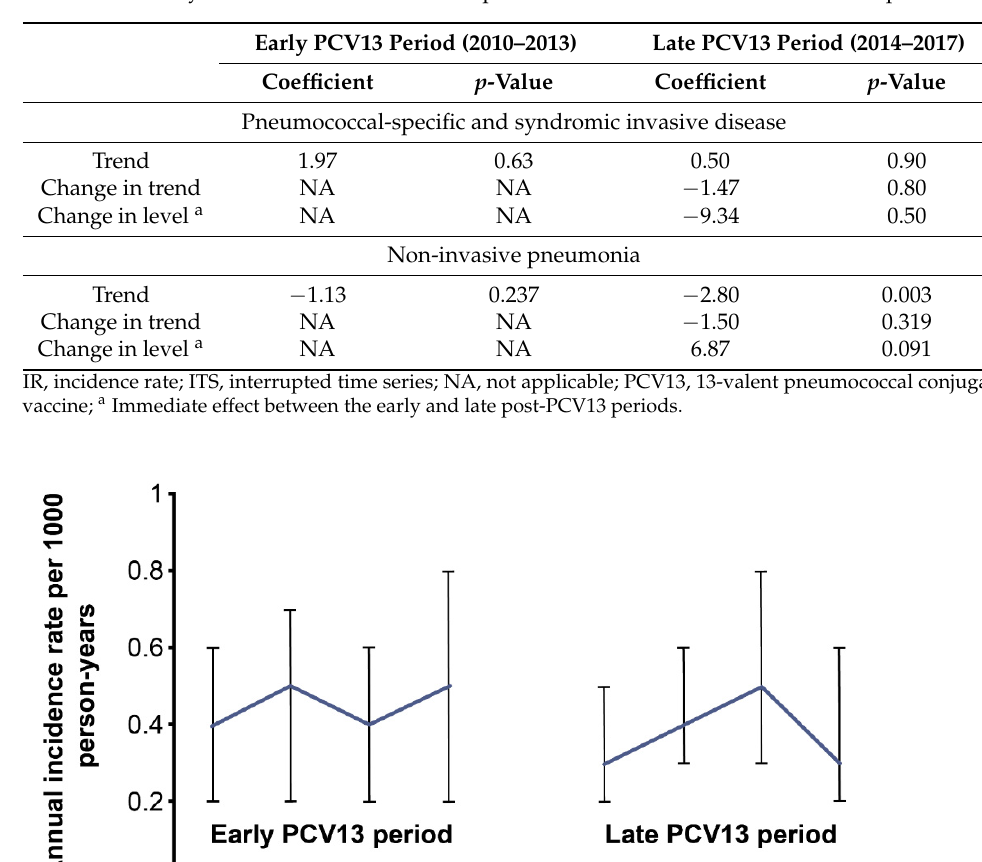
Table 4. Demographic characteristics and risk factors for non-invasive pneumonia in children . Non-Invasive Pneumonia (3926) Characteristic/Risk Factor